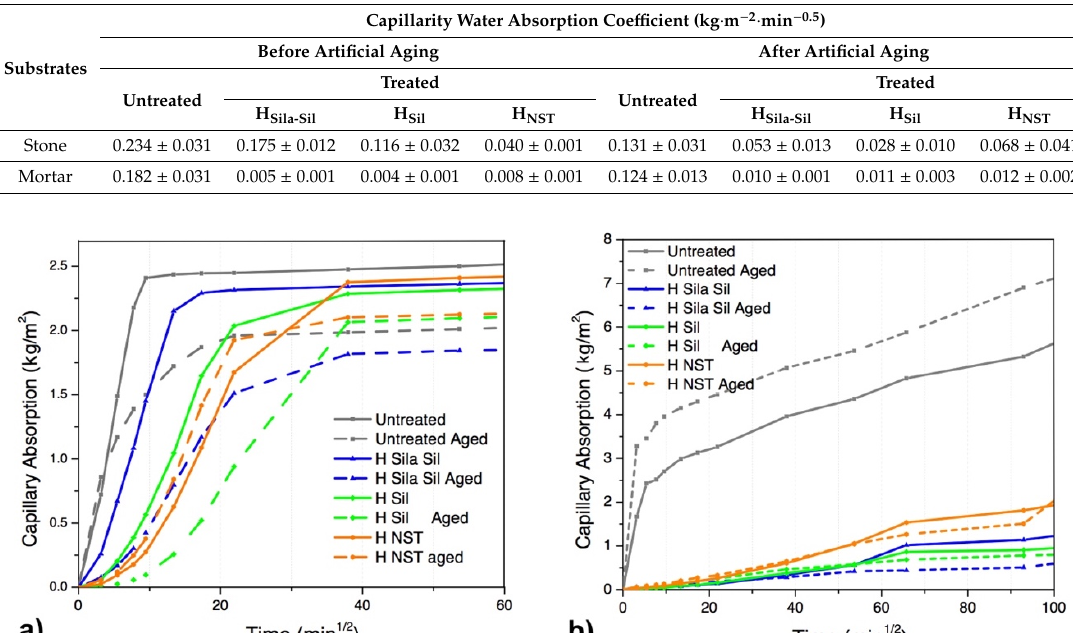
Figure 2. Capillary water absorption curves for the sound and treated substrates, before and after aging tests, of ( a ) limestone and ( b ) mortar, where solid lines are the unaged specimens, and dotted lines the aged